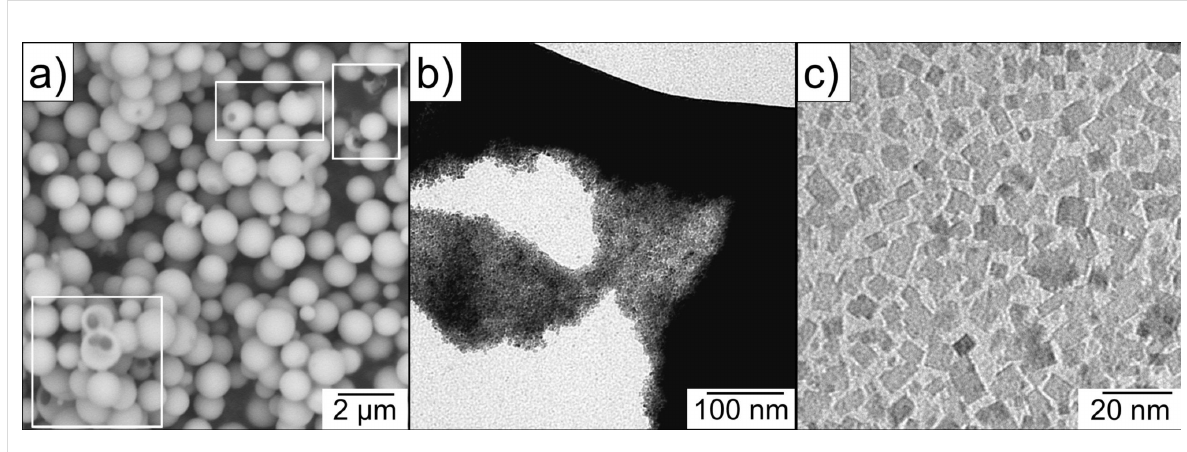
Figure 2: a) SEM and b) and c) TEM images of the Mn(II) glycolate particles. Particles with broken outer shells are highlighted by white frames in panel (a).